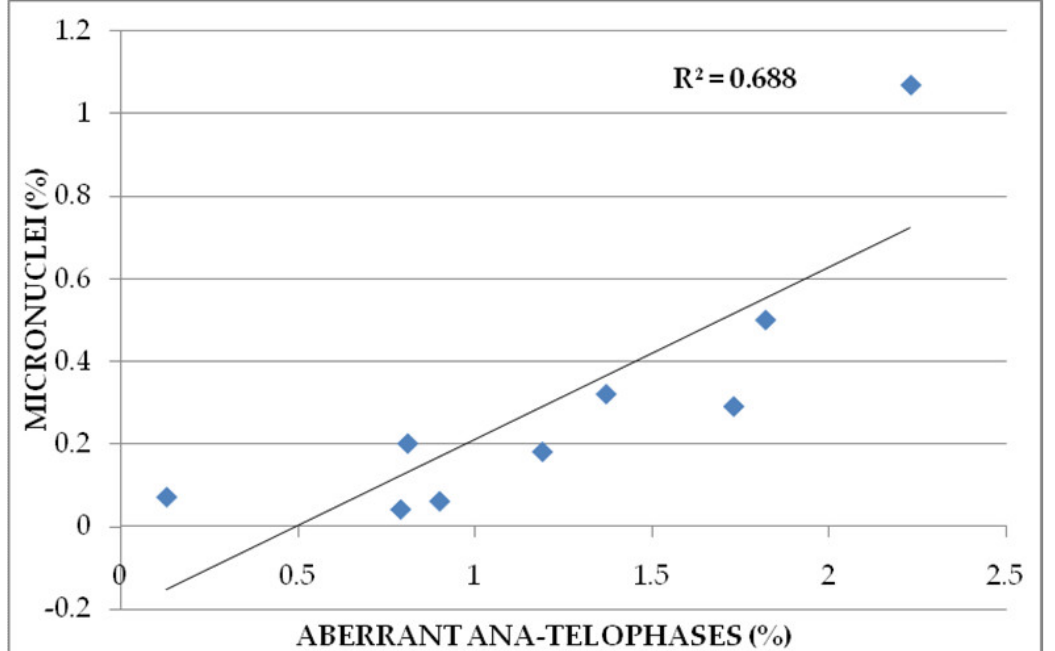
Figure 5. Correlation between genetic abnormalities (%) and mitotic index (%) in wheat root meristem cells treated with Merlot and Sauvignon blanc grape marc extracts.